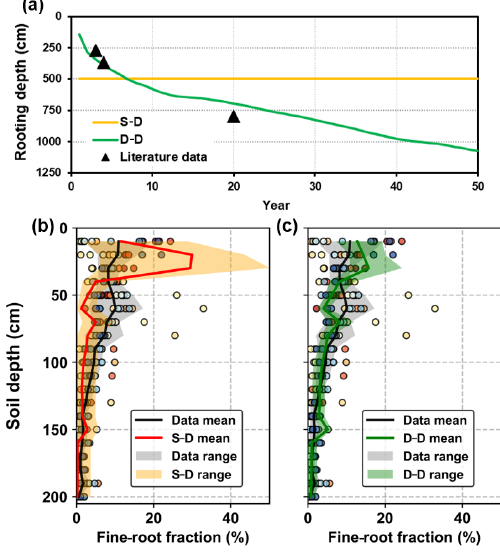
Figure 8. Evaluation of the simulated root distribution against the literature data: (a) rooting depth, (b) fine-root distribution in the top 2.0m soil layer for the static rooting depth approach (S–D), and (c) fine-root distribution in the top 2.0m soil layer for the dynamic rooting depth approach (D–D). The scatters with different colours illustrate the observational data from different literature sources, and the shaded areas illustrate the range of the mean ± standard de- viation of